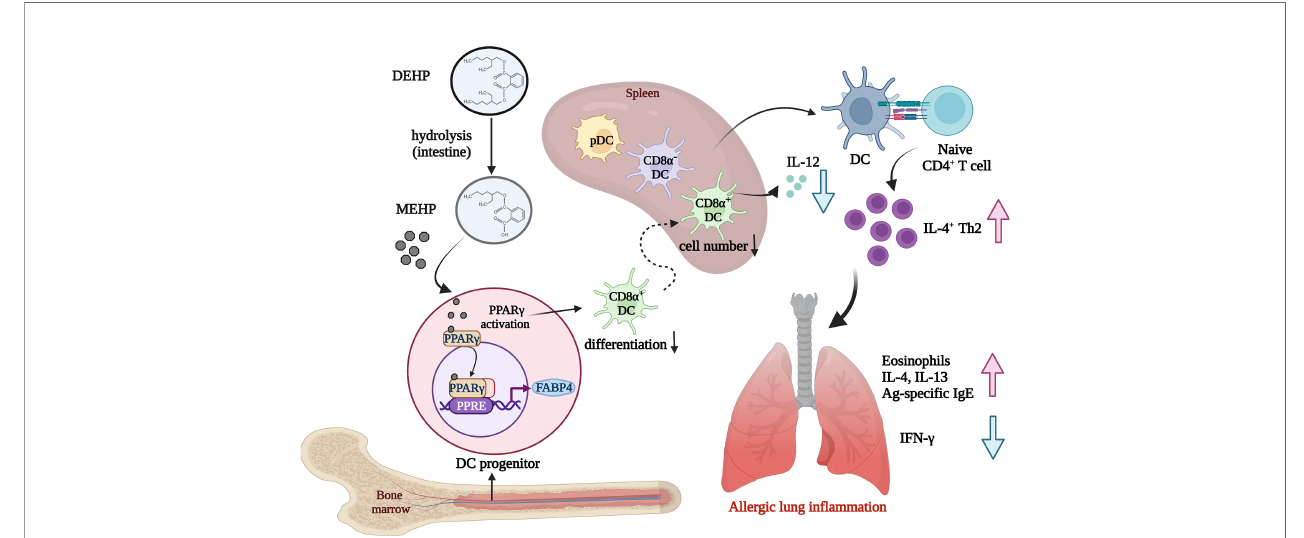
FIGURE 7 | Schematic representation showing the effect of environmental DEHP exposure on allergic lung in fl ammation. Chronic and low-level exposure to DEHP, a common plasticizer and environmental endocrine disruptor, may result in altered homeostasis of DC subsets, particularly block CD8 a + DC differentiation, through the MEHP-PPAR g activation axis. The loss of CD8 a + DCs, a main IL-12 cellular source, may contribute to the enhanced allergic lung in fl ammation, at least in part through Th2 polarization in DEHP-exposed mice. Image created with